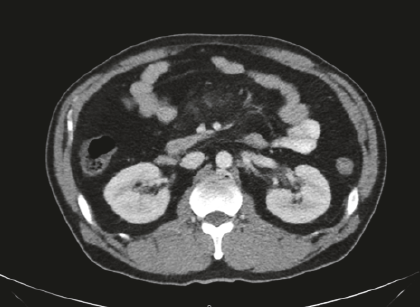
Figure3:Peripheralbloodsmearshowingpoikilocytosis,schistocy- tosis, thrombocytopenia, and a hypersegmented neutrophil